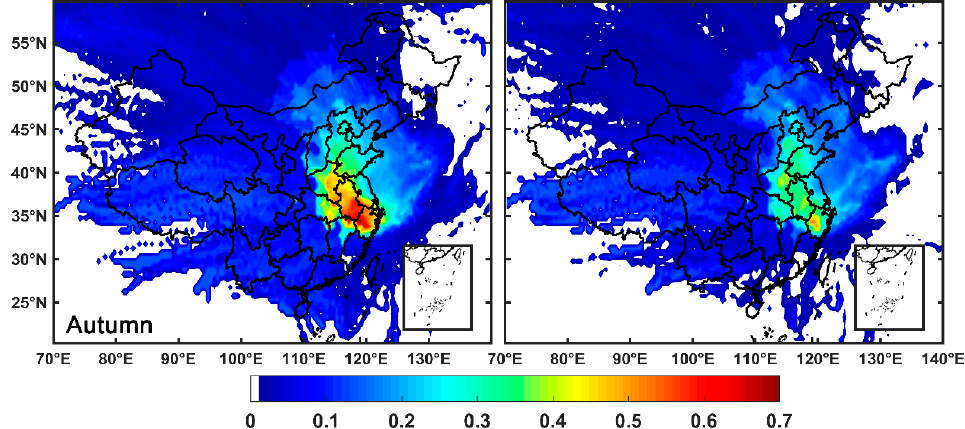
Figure 10. Source identification of NO 2 and SO 2 using the PSCF from 2014 to 2020 at annual and seasonal timescales in Jiangsu